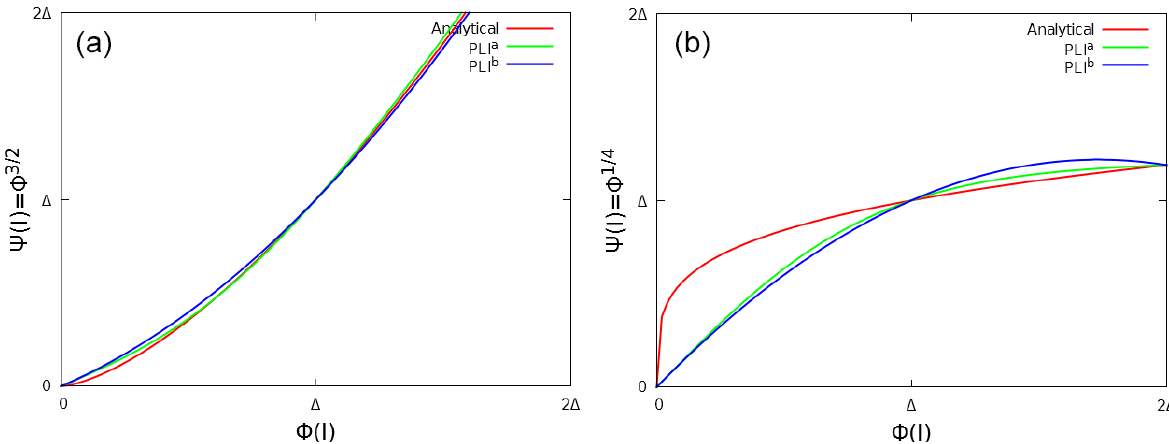
Figure 3. Quadratic interpolations of two analytical profiles ψ = φ n (red lines) using two image points at φ = −[ 1 ; 2 ] (cid:49) and the interface node. Green (blue) corresponds to L a ( L b ) polynomial